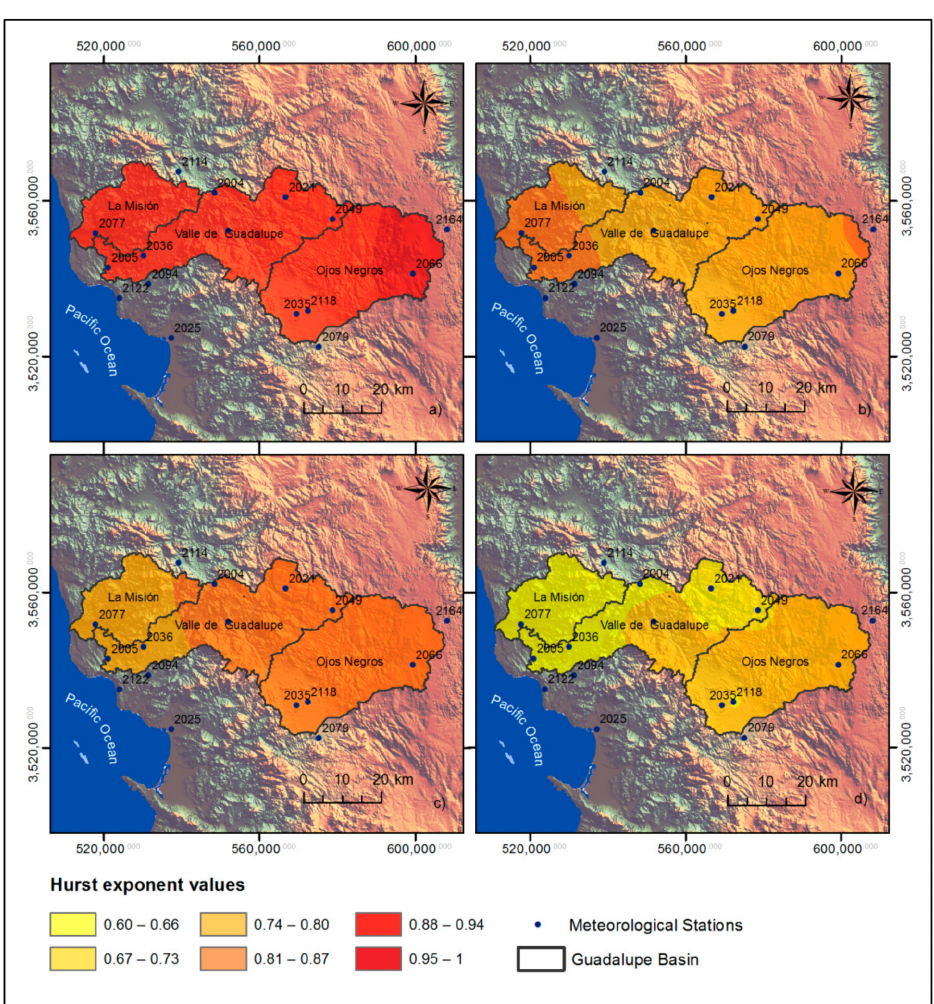
Figure 8. Maps of the Hurst exponent for the time series made up of days without Santa Ana winds and for the variables of ( a ) temperature, ( b ) pressure, ( c ) relative humidity, and ( d ) wind